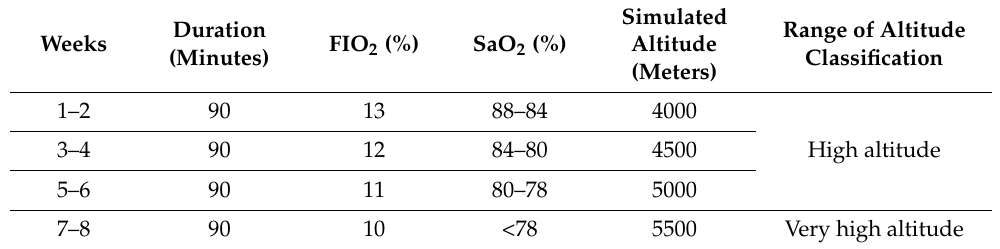
Table 3. The intermittent hypoxia exposure (IHE)